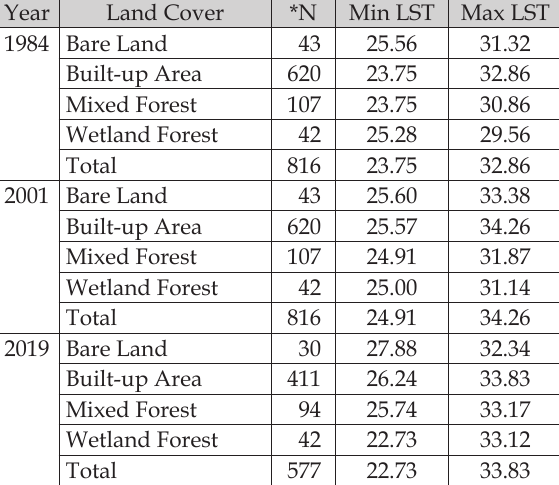
Table 3. Minimum and maximum LSTs [°C] associat - ed with the different land cover